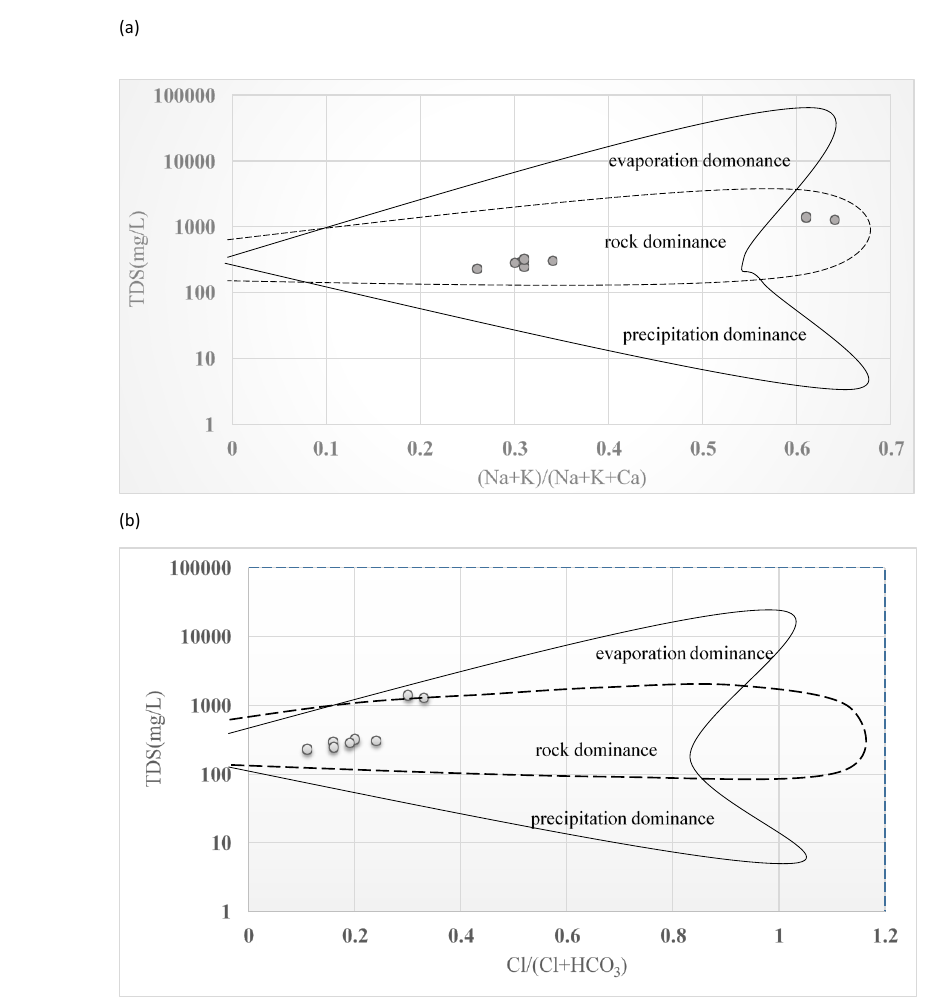
Fig. 6. Figure 6. The ratio of cations [(Na+K)/(Na+K+Ca)] and anions [Cl/(Cl+HCO (a) Gibbs plots representing the TDS versus Na/(Na+Ca) and (b) TDS versus Cl/(Cl+HCO3) in both seasons. A: Gibbs plots representing the TDS versus Na/(Na+Ca); and B: TDS versus Cl/(Cl+HCO